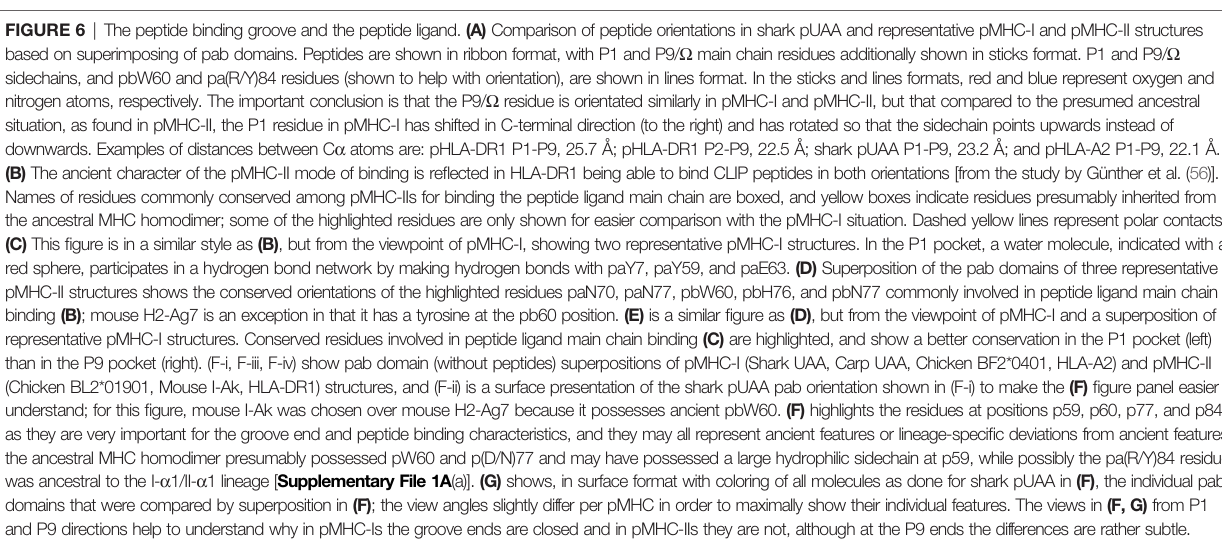
FIGURE 6 | The peptide binding groove and the peptide ligand. (A) Comparison of peptide orientations in shark pUAA and representative pMHC-I and pMHC-II structures based on superimposing of pab domains. Peptides are shown in ribbon format, with P1 and P9/ W main chain residues additionally shown in sticks format. P1 and P9/ W sidechains, and pbW60 and pa(R/Y)84 residues (shown to help with orientation), are shown in lines format. In the sticks and lines formats, red and blue represent oxygen and nitrogen atoms, respectively. The important conclusion is that the P9/ W residue is orientated similarly in pMHC-I and pMHC-II, but that compared to the presumed ancestral situation, as found in pMHC-II, the P1 residue in pMHC-I has shifted in C-terminal direction (to the right) and has rotated so that the sidechain points upwards instead of downwards. Examples of distances between C a atoms are: pHLA-DR1 P1-P9, 25.7 Å; pHLA-DR1 P2-P9, 22.5 Å; shark pUAA P1-P9, 23.2 Å; and pHLA-A2 P1-P9, 22.1 Å. (B) The ancient character of the pMHC-II mode of binding is re fl ected in HLA-DR1 being able to bind CLIP peptides in both orientations [from the study by Günther et al. (56)]. Names of residues commonly conserved among pMHC-IIs for binding the peptide ligand main chain are boxed, and yellow boxes indicate residues presumably inherited from the ancestral MHC homodimer; some of the highlighted residues are only shown for easier comparison with the pMHC-I situation. Dashed yellow lines represent polar contacts. (C) This fi gure is in a similar style as (B) , but from the viewpoint of pMHC-I, showing two representative pMHC-I structures. In the P1 pocket, a water molecule, indicated with a red sphere, participates in a hydrogen bond network by making hydrogen bonds with paY7, paY59, and paE63. (D) Superposition of the pab domains of three representative pMHC-II structures shows the conserved orientations of the highlighted residues paN70, paN77, pbW60, pbH76, and pbN77 commonly involved in peptide ligand main chain binding (B) ; mouse H2-Ag7 is an exception in that it has a tyrosine at the pb60 position. (E) is a similar fi gure as (D) , but from the viewpoint of pMHC-I and a superposition of representative pMHC-I structures. Conserved residues involved in peptide ligand main chain binding (C) are highlighted, and show a better conservation in the P1 pocket (left) than in the P9 pocket (right). (F-i, F-iii, F-iv) show pab domain (without peptides) superpositions of pMHC-I (Shark UAA, Carp UAA, Chicken BF2*0401, HLA-A2) and pMHC-II (Chicken BL2*01901, Mouse I-Ak, HLA-DR1) structures, and (F-ii) is a surface presentation of the shark pUAA pab orientation shown in (F-i) to make the (F) fi gure panel easier to understand; for this fi gure, mouse I-Ak was chosen over mouse H2-Ag7 because it possesses ancient pbW60. (F) highlights the residues at positions p59, p60, p77, and p84, as they are very important for the groove end and peptide binding characteristics, and they may all represent ancient features or lineage-speci fi c deviations from ancient features; the ancestral MHC homodimer presumably possessed pW60 and p(D/N)77 and may have possessed a large hydrophilic sidechain at p59, while possibly the pa(R/Y)84 residue was ancestral to the I- a 1/II- a 1 lineage [ Supplementary File 1A (a)]. (G) shows, in surface format with coloring of all molecules as done for shark pUAA in (F) , the individual pab domains that were compared by superposition in (F) ; the view angles slightly differ per pMHC in order to maximally show their individual features. The views in (F, G) from P1 and P9 directions help to understand why in pMHC-Is the groove ends are closed and in pMHC-IIs they are not, although at the P9 ends the differences are rather